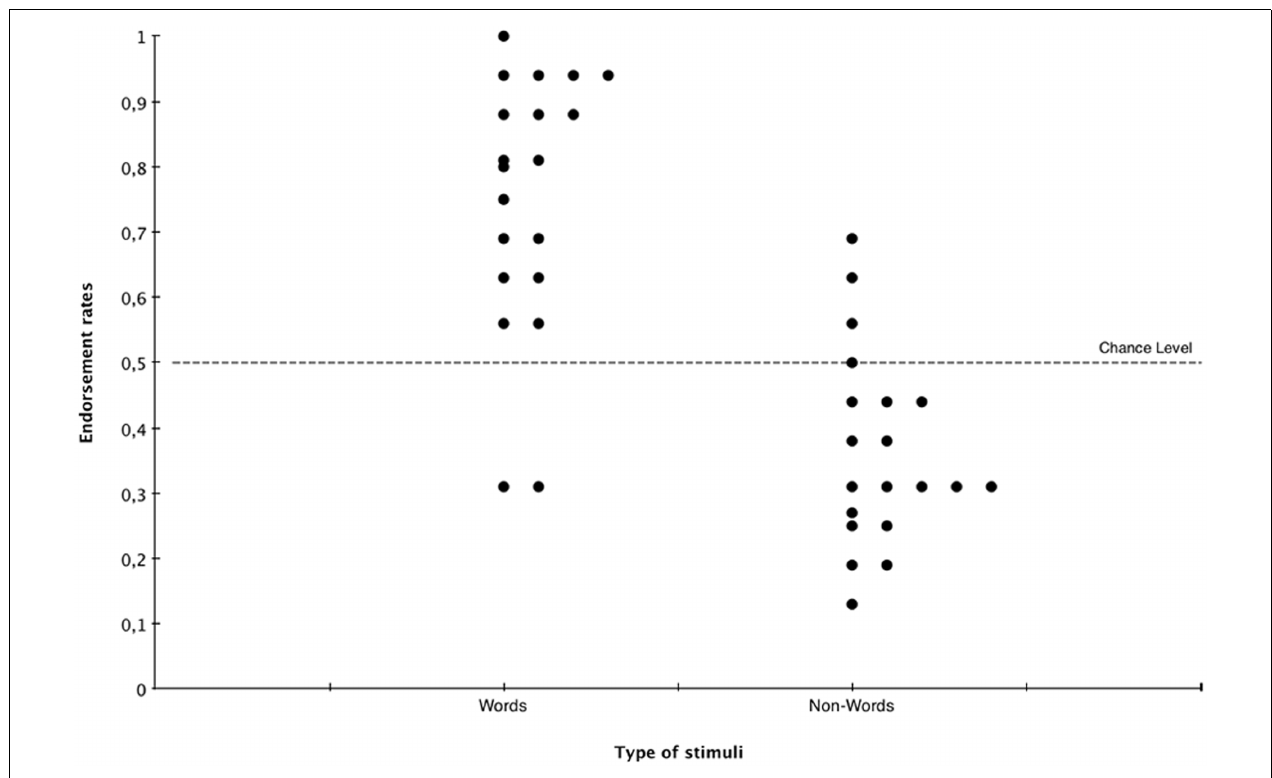
FIGURE 2 | Endorsement rates for words and for non-words in the recognition